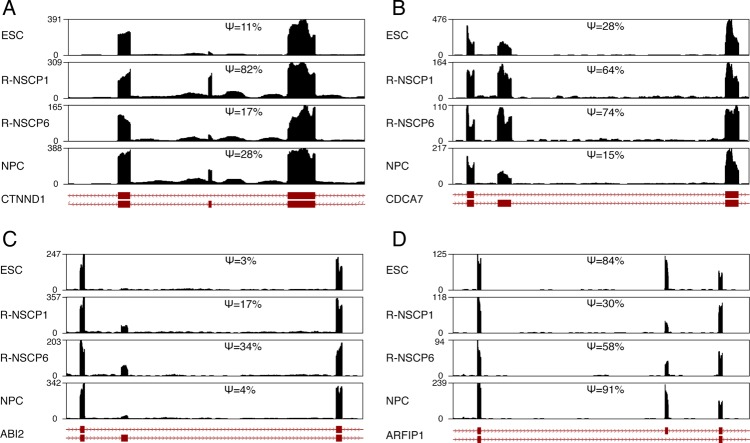
Examples of R-NSC-specific AS changes during rhesus ESC neural differentiation. The RNA-Seq reads coverage of alternative exons and the flanking exons in CTNND1, CDCA7, ABI2, and ARFIP1 are shown in A–D, respectively. The y-axes represent read coverage; the inclusion level (Ψ) of each alternative exon on each stage is shown. Three-exon isoform structures are shown at the bottom of each panel, and the middle exon is the alternative exon.